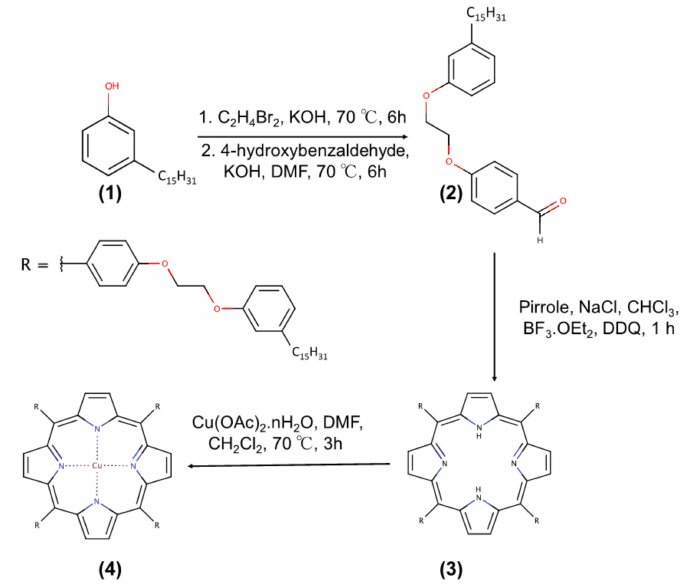
Figure 1. Synthetic scheme for porphyrins from cardanol: ( 1 ) hydrogenated cardanol; ( 2 ) aldehyded precursor; ( 3 ) H 2 Pp; ( 4 )